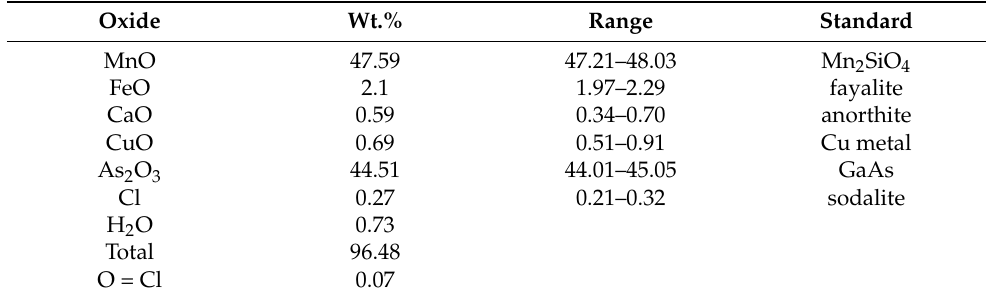
Table 1. Chemical analyses of magnussonite. Oxide Wt.% Range Standard